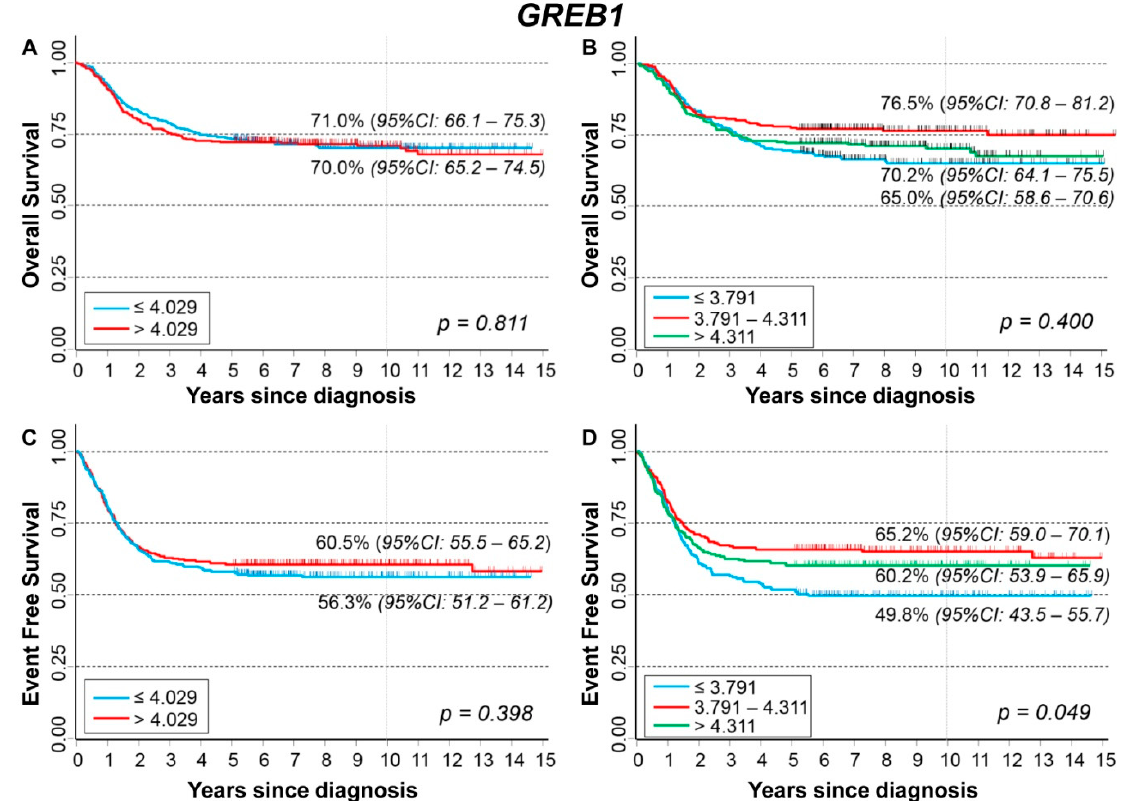
cut ‐ off based on the median expression value or ( D ) on tertile expression values. Ten ‐ year survival estimates are displayed.